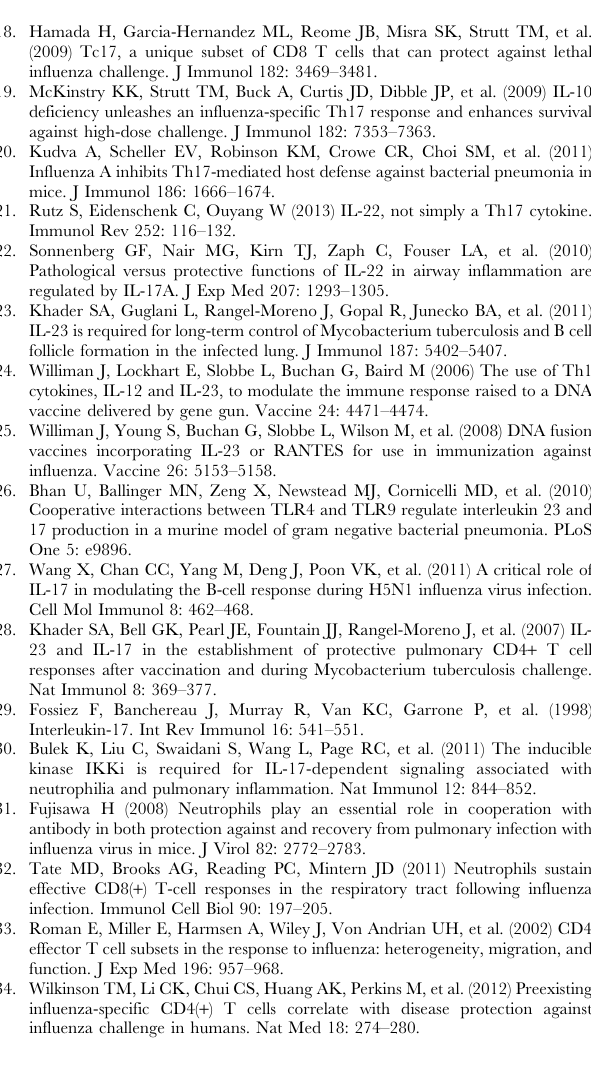
Figure S4 Neutralization of IL-17A or neutrolphil abla- tion does not alter polyfunctional influenza